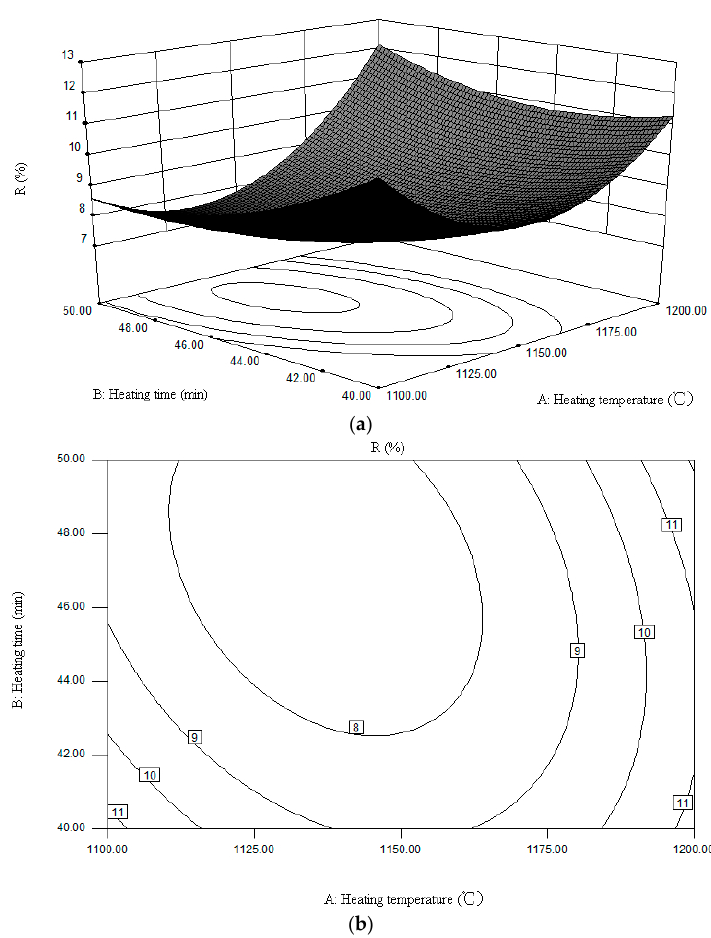
Figure 6. ( a ) Response surfaces of heating temperature–time and ( b ) contour of heating temperature–time plot.